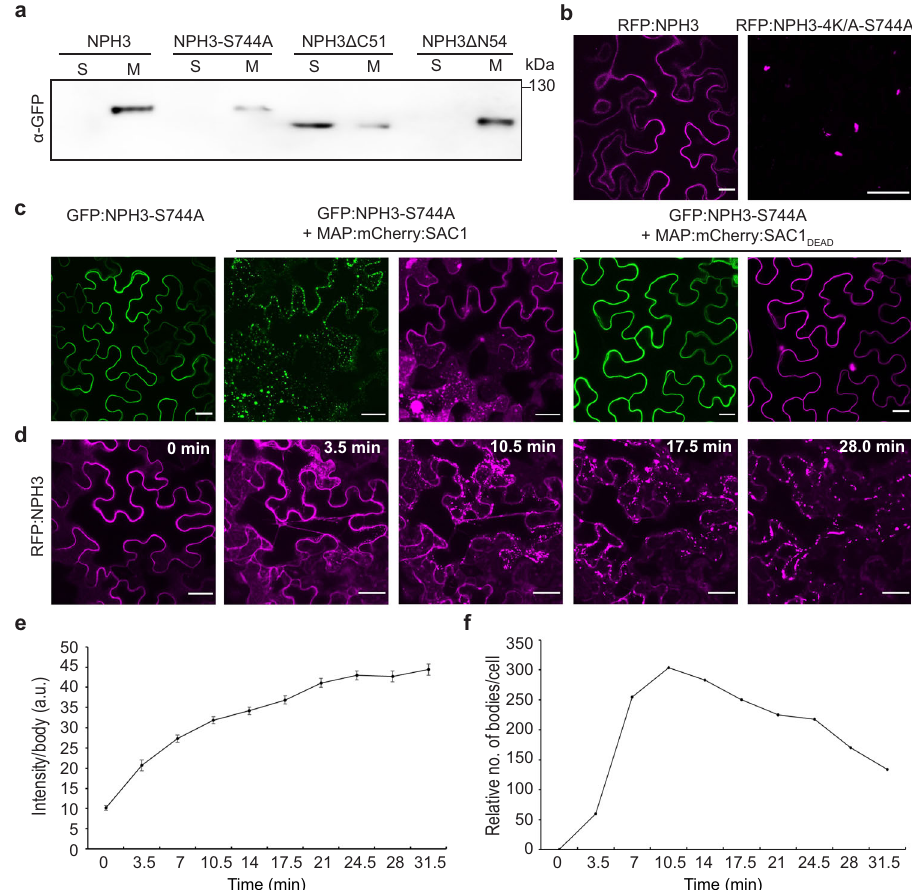
Fig. 5 Formation of membraneless NPH3 condensates is independent of 14-3-3 binding. a Representative anti-GFP immunoblots following subcellular fractionation of protein extracts prepared from dark-adapted N. benthamiana leaves transiently expressing GFP:NPH3 variants. Expression was driven by the 35S promoter. Proteins in each fraction (7.5 μ g) were separated on 7.5% SDS-PAGE gels. It is noteworthy that the total amount of soluble proteins (S) is ~15 times higher as compared to the total amount of microsomal proteins (M) after 100,000 × g centrifugation. b Representative confocal microscopy images of leaf epidermal cells from dark-adapted N. benthamiana transiently expressing RFP:NPH3-4K/A-S744A. Z -stack projection is shown. Expression was driven by the 35S promoter. RFP:NPH3 is shown as control. Scale bars, 25 μ m. c Representative confocal microscopy images of leaf epidermal cells from dark-adapted N. benthamiana transiently co-expressing GFP:NPH3-S744A and either MAP:mCherry:SAC1 or MAP:mCherry:SAC1 DEAD . Expression was driven by the 35S promoter. Z -stack projection of GFP:NPH3-S744A co-expressed with MAP:mCherry:SAC1 is shown. Single expression of GFP:NPH3- S744A is shown as control. Scale bars, 25 μ m. d – f Single-cell time-lapse imaging of RFP:NPH3 condensation induced by GFP laser treatment of transiently transformed and dark-adapted N. benthamiana . Expression was driven by the 35S promoter. The image of time point 0 was taken in the absence of the GFP laser. Z -stack projections from selected time points of blue light treatment ( d ), fl uorescence intensity per body (mean± SEM) ( e ), and number of bodies ( f ) are shown. One representative experiment of fi ve replicates is shown. Scale bars, 25 μ m. Experiments a – c were performed at least three times with similar